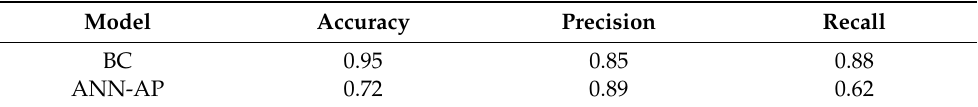
Table 2. BC model and ANN-AP training results. The binary classification models were trained on round 5 and the performance metrics (accuracy, precision, and recall) were computed by confu- sion matrix. Model